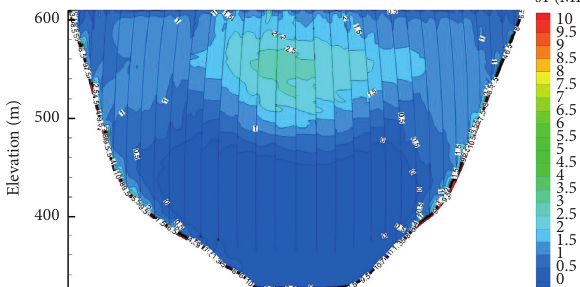
Figure 19: Envelope of maximum principal tensile stress distri- bution of upstream surface of the dam for no-slip condition [13].